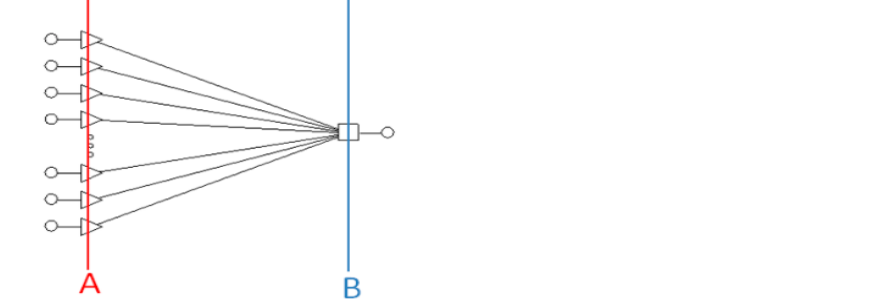
Figure 1. Structure of a linear network with single output. A—input layer and B—output layer.